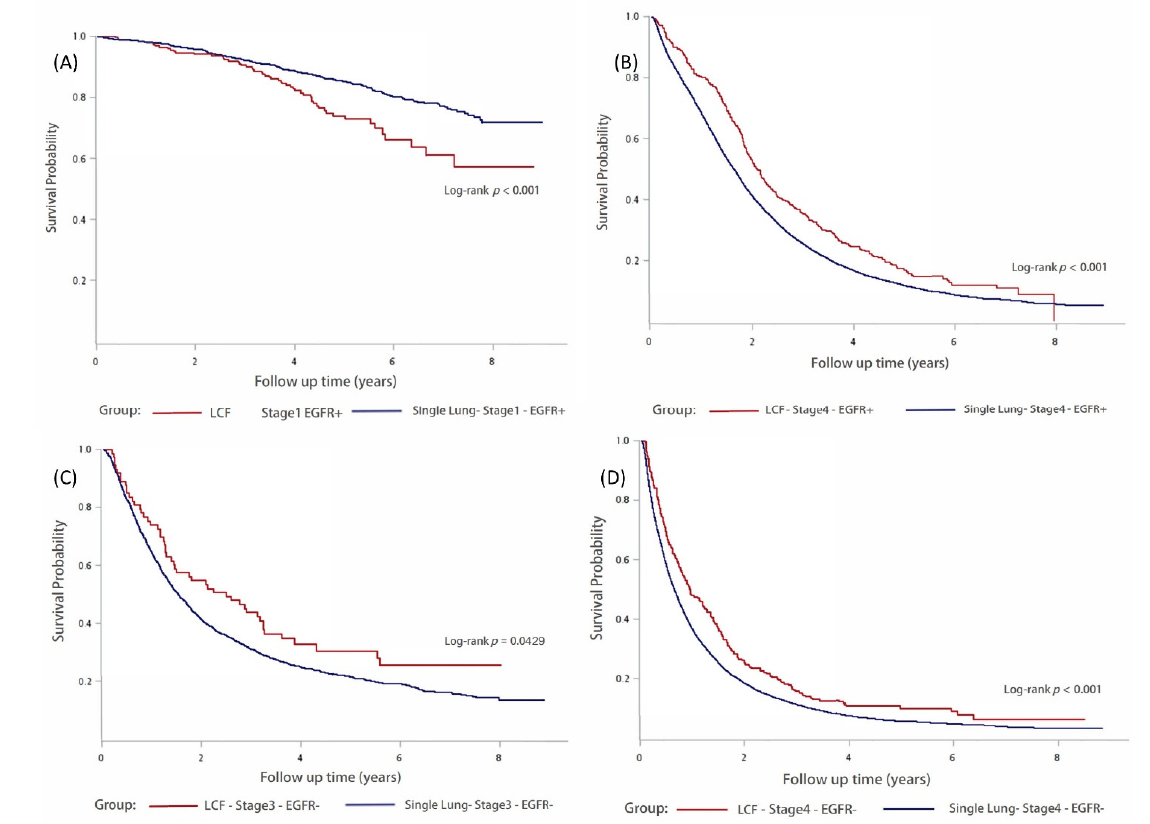
Figure 3. Kaplan–Meier analyses of overall survival between LCF and single lung cancer based on cancer stage and EGFR expression. ( A ) stage 1 patients with EGFR mutations, ( B ) stage 4 patients with EGFR mutations, ( C ) stage 3 patients with undetected EGFR, ( D ) stage 4 patients with undetected EGFR. EGFR: epidermal growth factor receptor; LCF: lung cancer first.